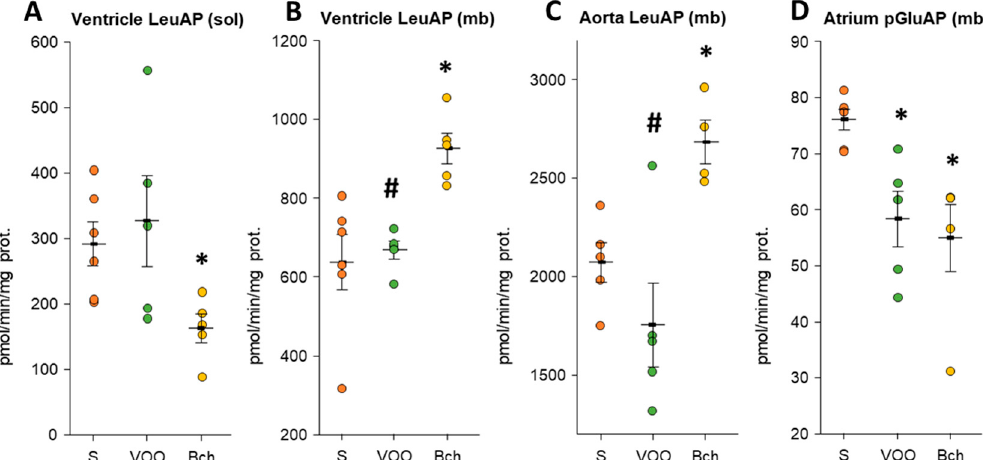
Figure 4. Mean values ± standard errors of significant ( A – C ) leucyl aminopeptidase (LeuAP) and ( D ) pyroglutamyl aminopeptidase (pGluAP) activities in soluble and membrane-bound (mb) fractions of atrium, ventricle, and aorta. The small colored dots are data points per group. Values are expressed as pmol/min/mg prot in the rest of the tissues analyzed. * indicates significant differences between virgin olive oil diet (VOO) or butter plus cholesterol diet (Bch) vs. standard diet (S), * p < 0.05. # indicates significant differences between VOO and Bch, # p < 0.05.